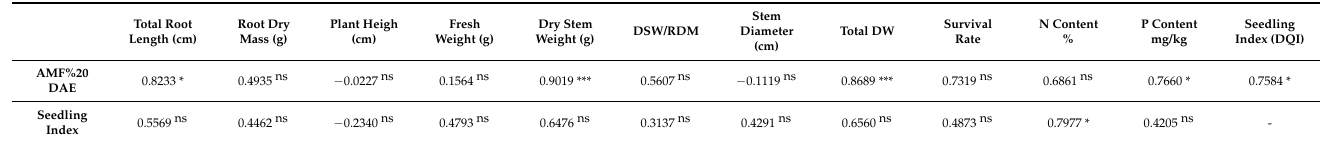
Table 3. Correlation matrix between agronomic characteristics, nutrient content, AMF percentage and Dickson’s quality index. TotalRoot RootDry Length(cm)